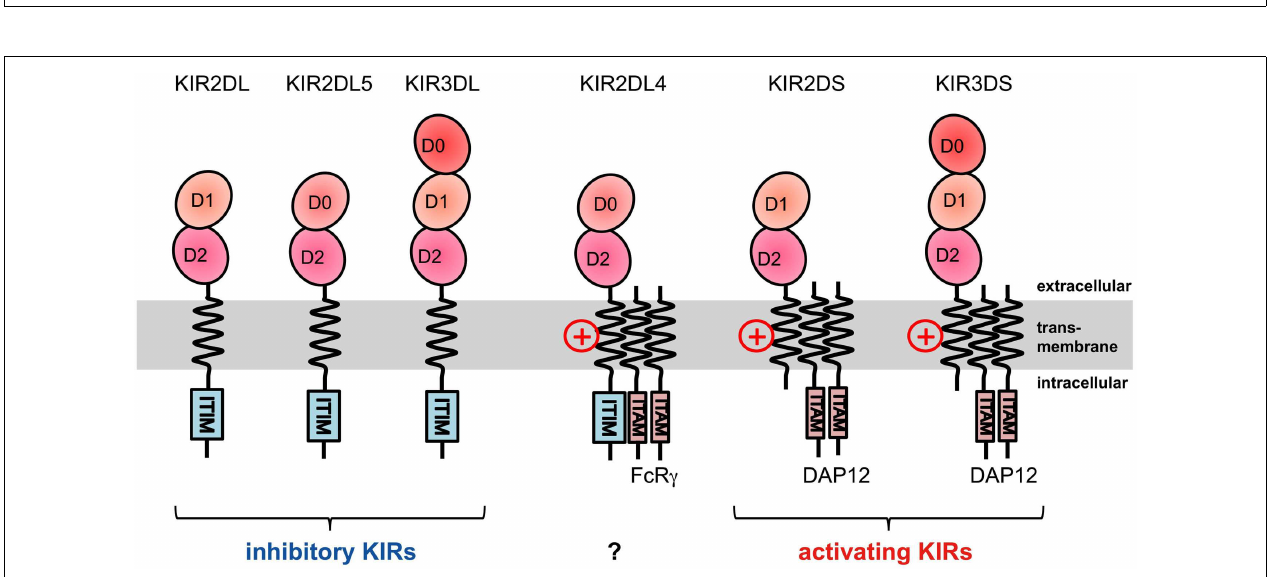
FIGURE 1 | (A) Schematic representation of the LRC on human chromosome 19q13.4. A large number of Ig-like receptor genes, including two clusters of LILR loci and a cluster of KIR loci, are encoded within the LRC. Arrows indicate the direction of transcription for each gene.These loci have evolved by multiple duplications, and the two LILR clusters are likely to have been generated by the inverse duplication of an ancient one. (B) The hypothesis of paired receptor family evolution. I) The NK cell possesses at least one inhibitory receptor (cyan), and the